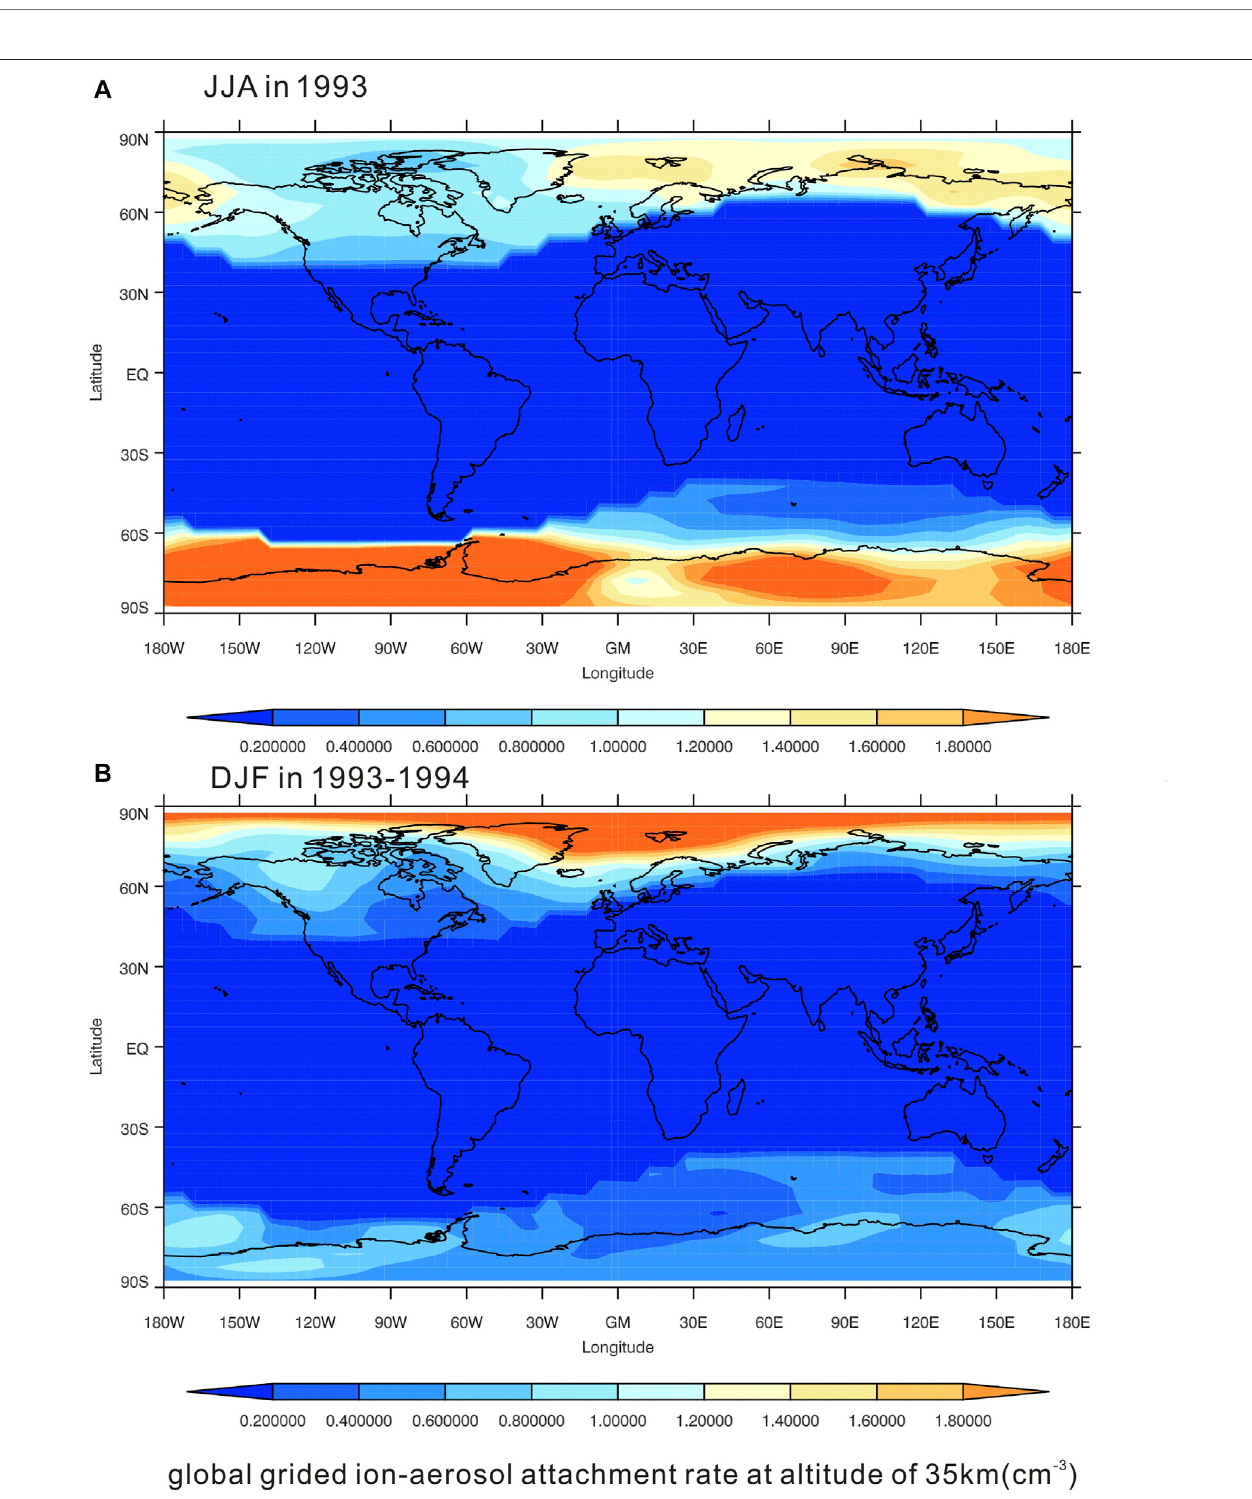
FIGURE 6 | Global ion-aerosol attachment rate at a height of 35 km, (A) for JJA in 1993 and (A) for DJF in 1993 – 1994.